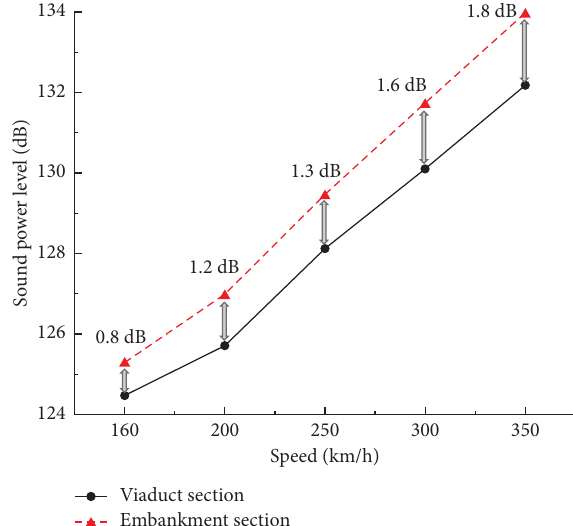
Figure 7: Sound power level of all acoustic image regions at different speeds in the viaduct and embankment